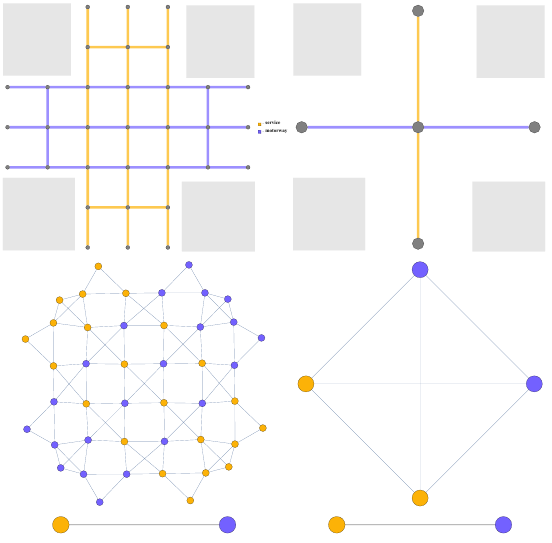
Figure4. Twopossibleprimarygraphsforthesamecrossroad. Left: asquarelattice,it’slinegraphand Figure 4. Two possible primary graphs for the same crossroad. ( left ) a square lattice, its line graph and theresultingcontraction. Right: thesimplestprimarygraphandthecorrespondinglinegraphthat giverisetothesameresult. the resulting contraction; ( right ) the simplest primary graph and the corresponding line graph that give rise to the same